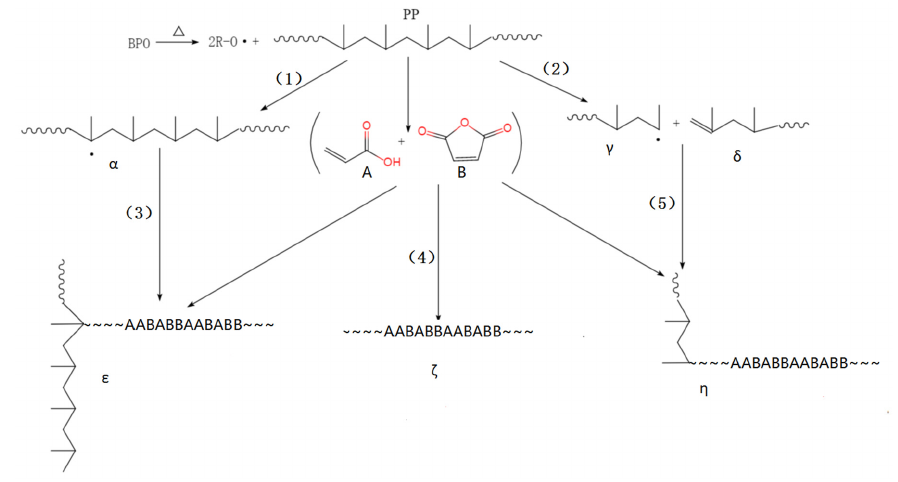
Figure 3. The mechanism of suspension grafting polymerization of AA and MAH monomers.